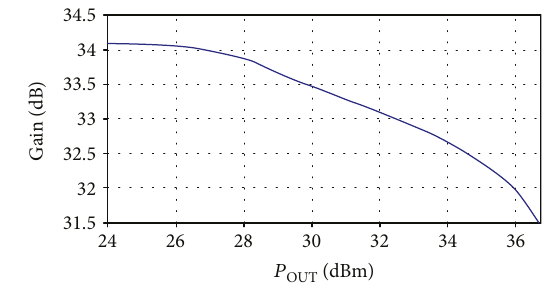
Figure 11: Measured gain of PA (SZM-2166Z).